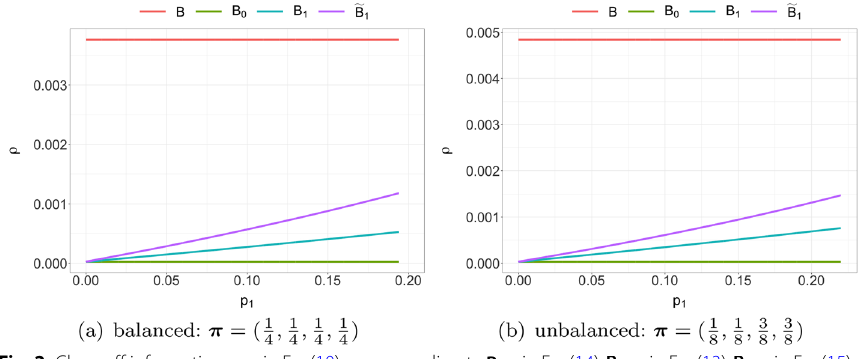
Fig. 2 Chernoff information ρ as in Eq. (10) corresponding to B as in Eq. (14), B 0 as in Eq. (13), B 1 as in Eq. (15),